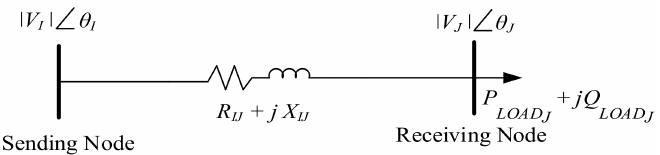
Figure 1. Line segment of radial DN from node I to node J